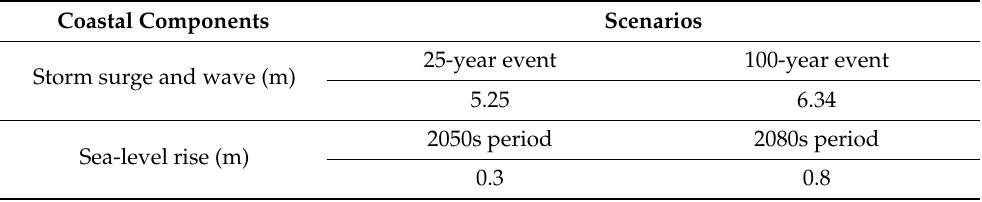
Table 1. The components considered in coastal flood assessments under climate